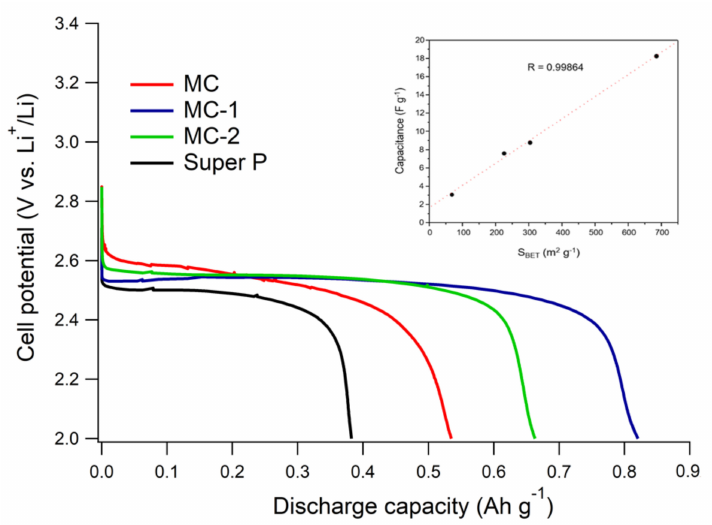
Figure 6. Galvanostatic measurements of carbons / SS mesh electrodes at 60 ◦ C at 0.1 mA cm − 2 using a sandwich cell configuration and (inset) a graph plotting the capacitance (F g − 1 ) versus S BET